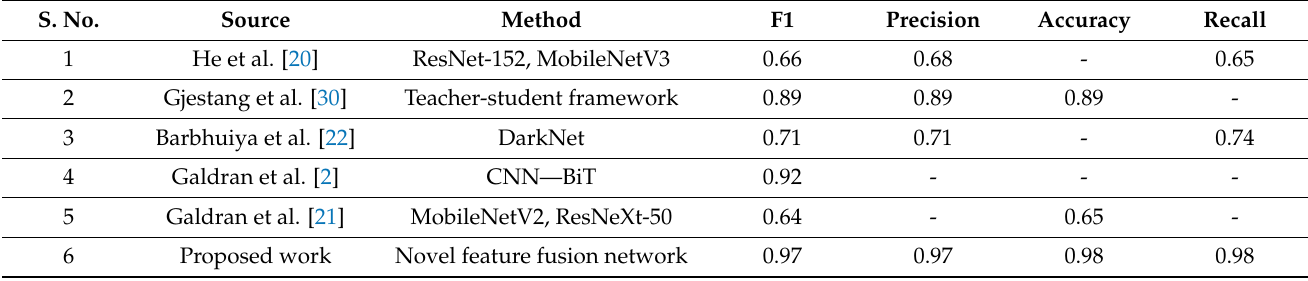
Table 5. Performance comparison of the proposed network against existing